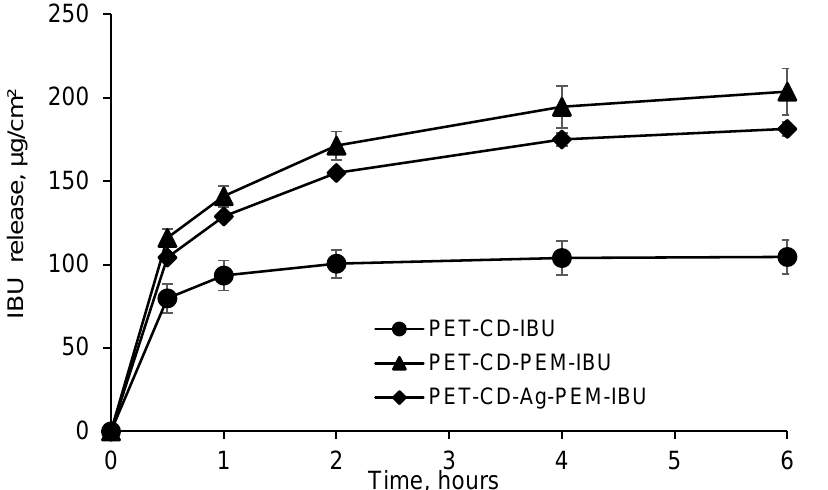
Figure 7. Kinetics release of ibuprofen lysinate (IBU-L) in batch, expressed in μg/cm 2 (PBS pH 7.4, 37 °C, 80 rpm) from PET-CD-IBU, PET-CD-PEM-IBU and PET-CD-Ag-PEM-IBU dressings.